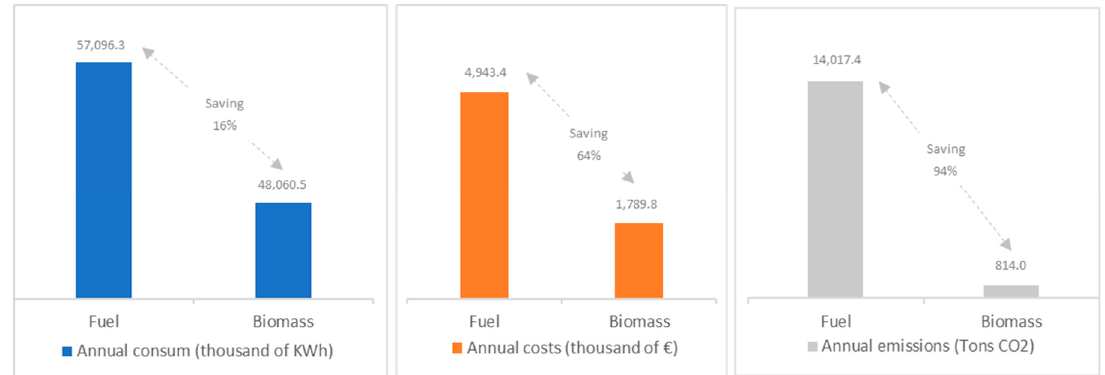
Figure 4. Extrapolation to the entire Pontevedra province. Optimum scenario (complete results in Table A12 in the Appendix A).